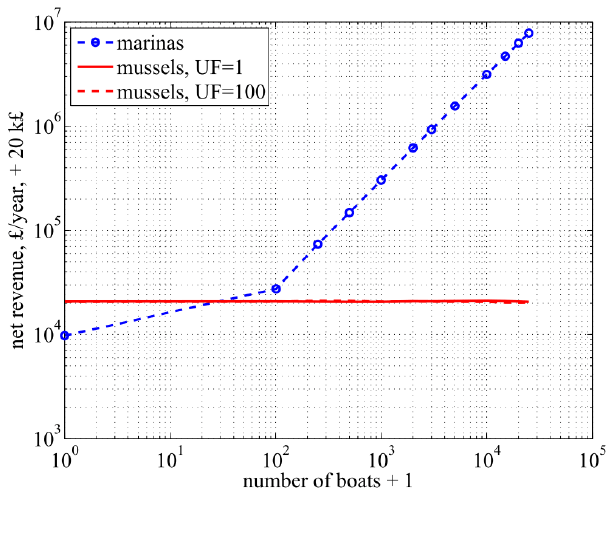
Fig. 6 . Model results: Performance of mussel farm and marinas under different scenarios (of numbers of berths in marinas, corresponding to maximum number of visiting boats) and 2 values of the anit-fouling compounds (AFC) uncertainty factor (UF). The indicator values are annual total revenues net of